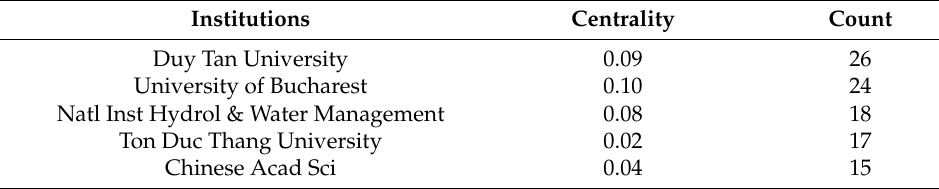
Table 5. Five most influential institutions in the research